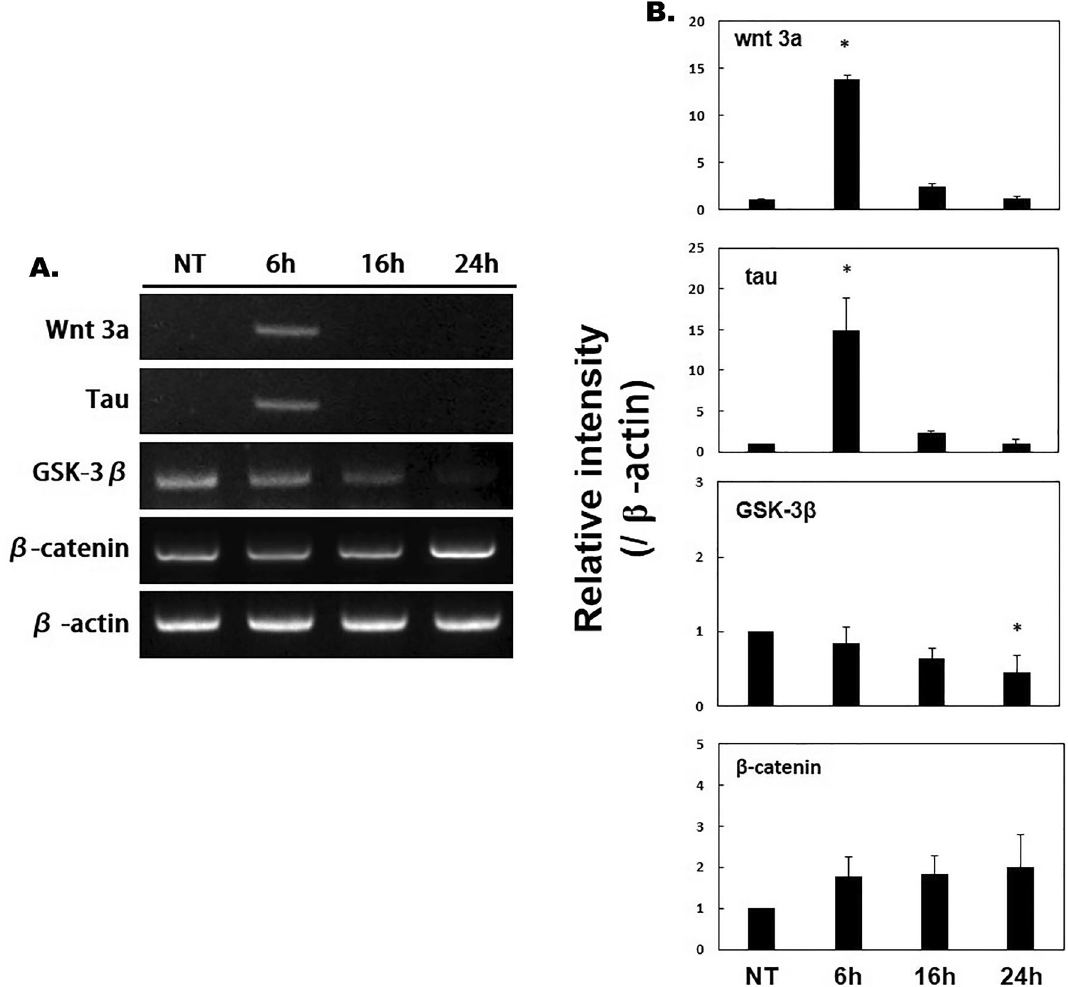
Figure 4. RT-PCR of SH-SY5Y cell extracts. Tau and wnt3a were highly expressed after 6 h of NTP treatment. β-catenin was highly expressed after 24 h of NTP treatment. GSK3β expression was reduced after 24 h of NTP treatment. *Indicates p <